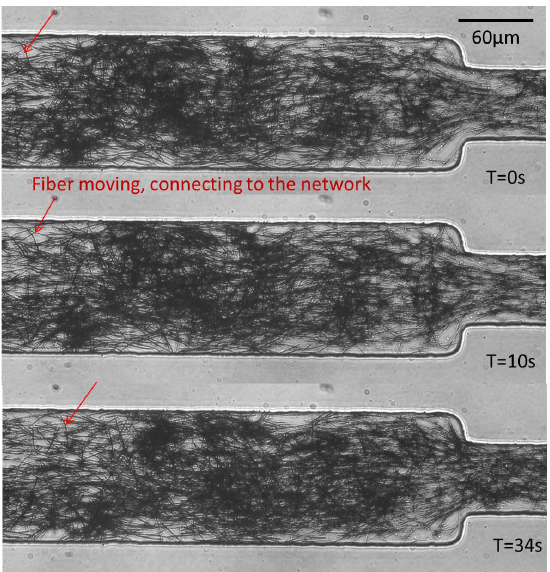
Figure 19. Formation of a network of fibers, all flowing at the same velocity, extending over the channel width. Fiber density fluctuations can be seen between the three pictures; however, all fibers have flown by the same